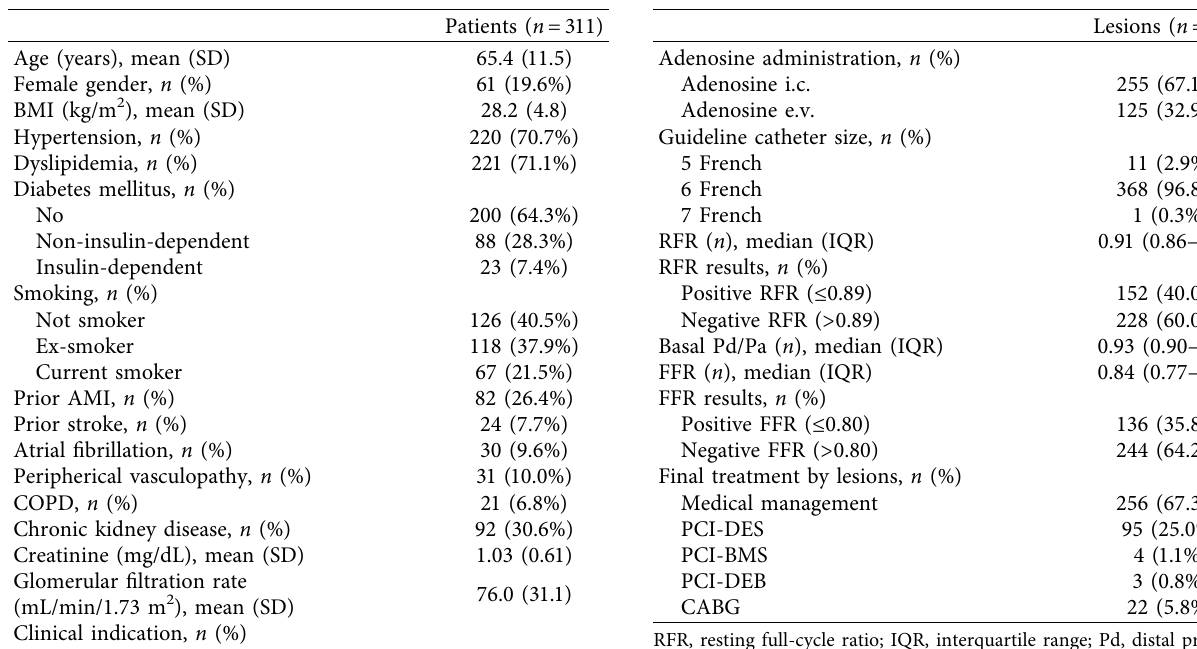
Table 3: Physiological characteristics and final treatment. Table 1: Baseline clinical